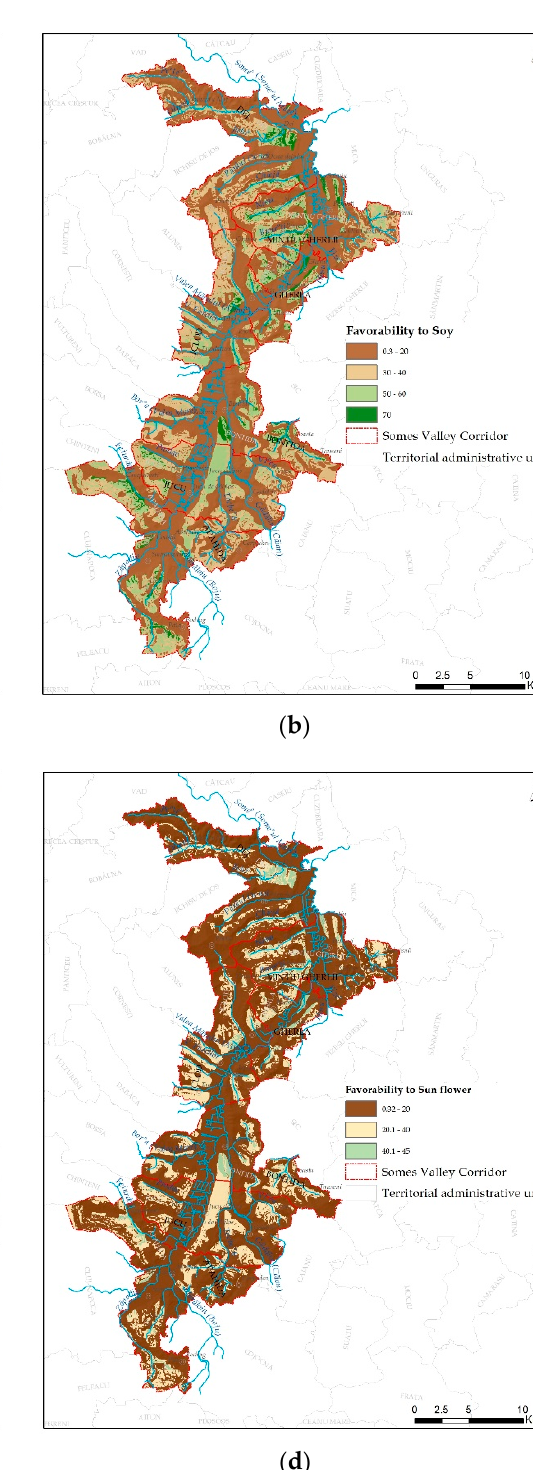
Figure 4. ( a ) Land favourability for barley. ( b ) Land favourability for corn. ( c ) Land favourability for potato. ( d ) Land favourability for wheat.